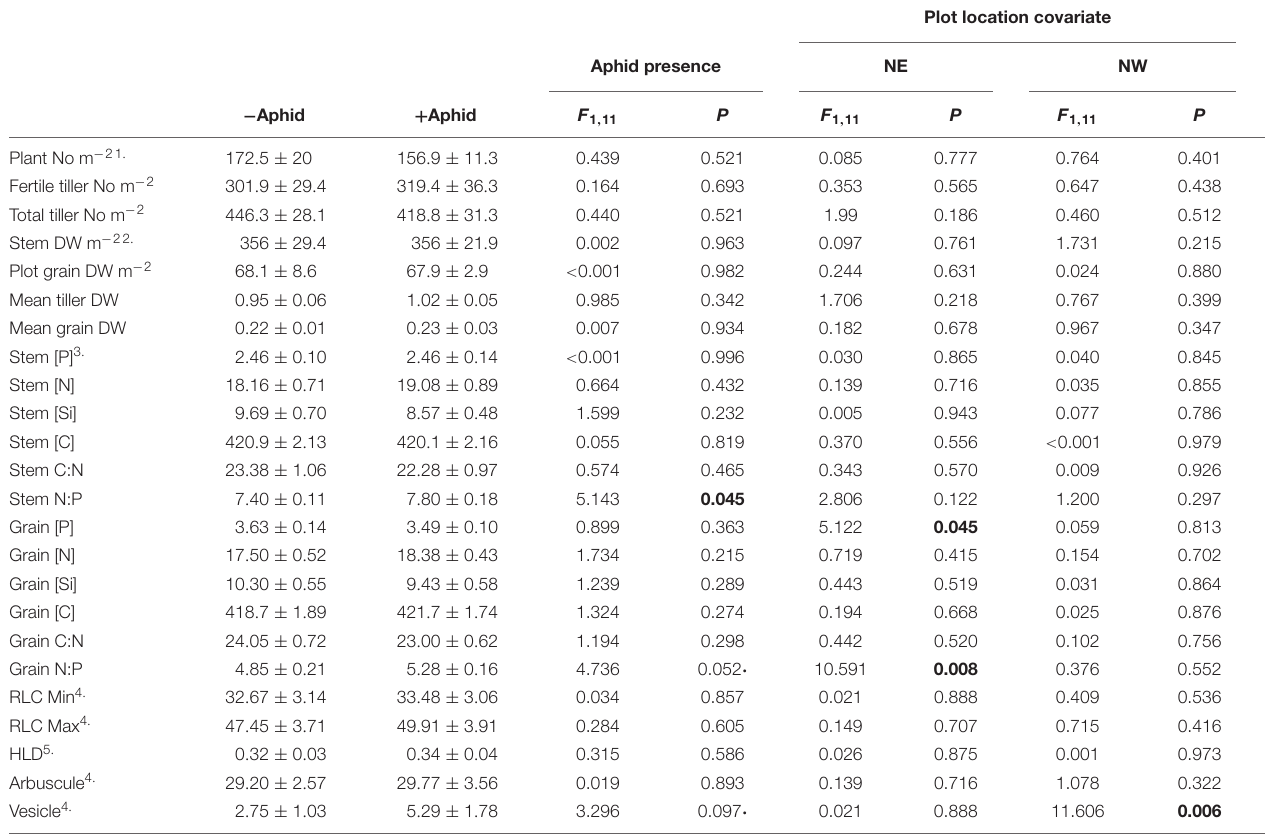
TABLE 3 | Mean ( ± SE) above-ground plant biomass and nutrient concentrations, and AMF structures of experimental barley plots treated with or without aphids, using the location of the plot in the NE and NW direction of the site as a model covariate.